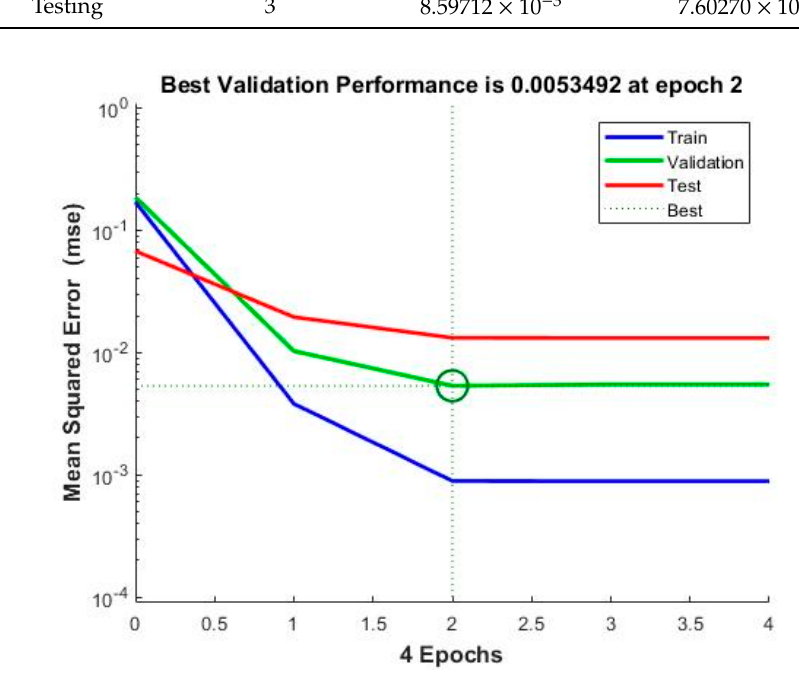
Figure 6. Performance curve.